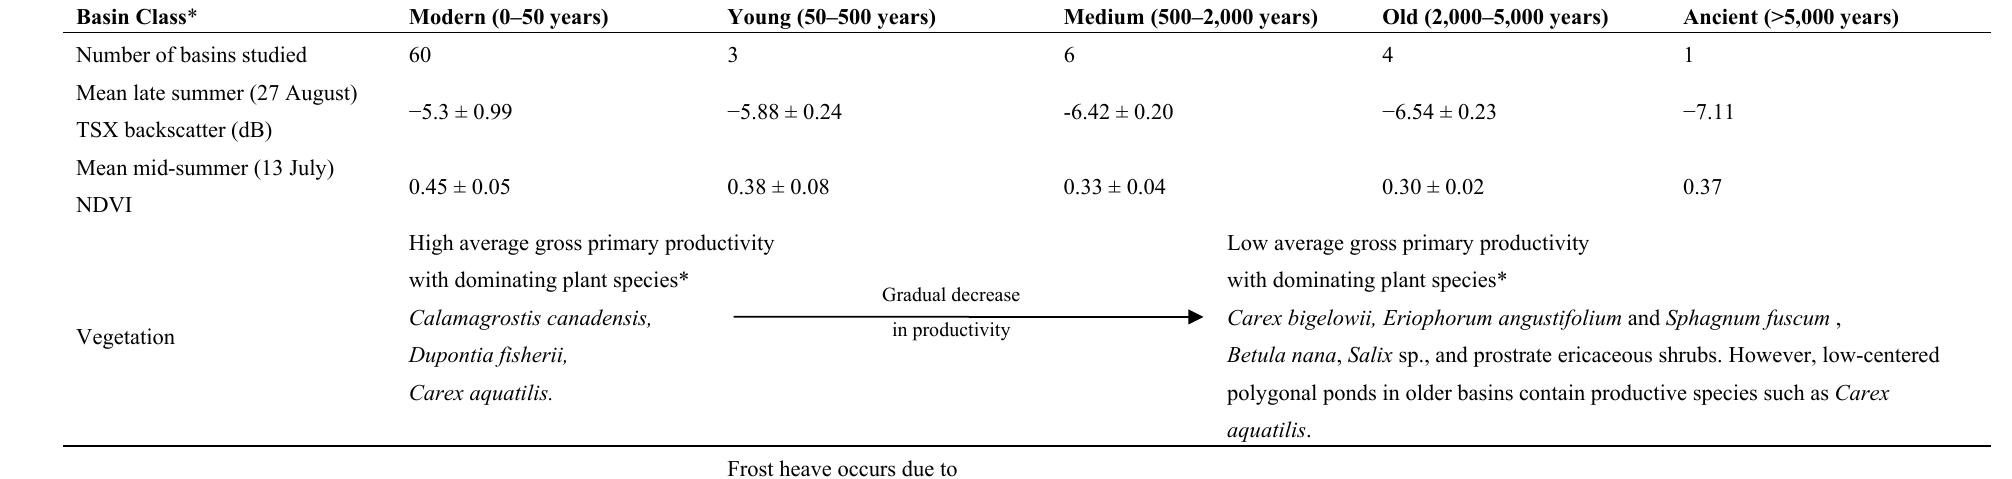
Table 2. Characteristics of basins of different age on the northern Seward